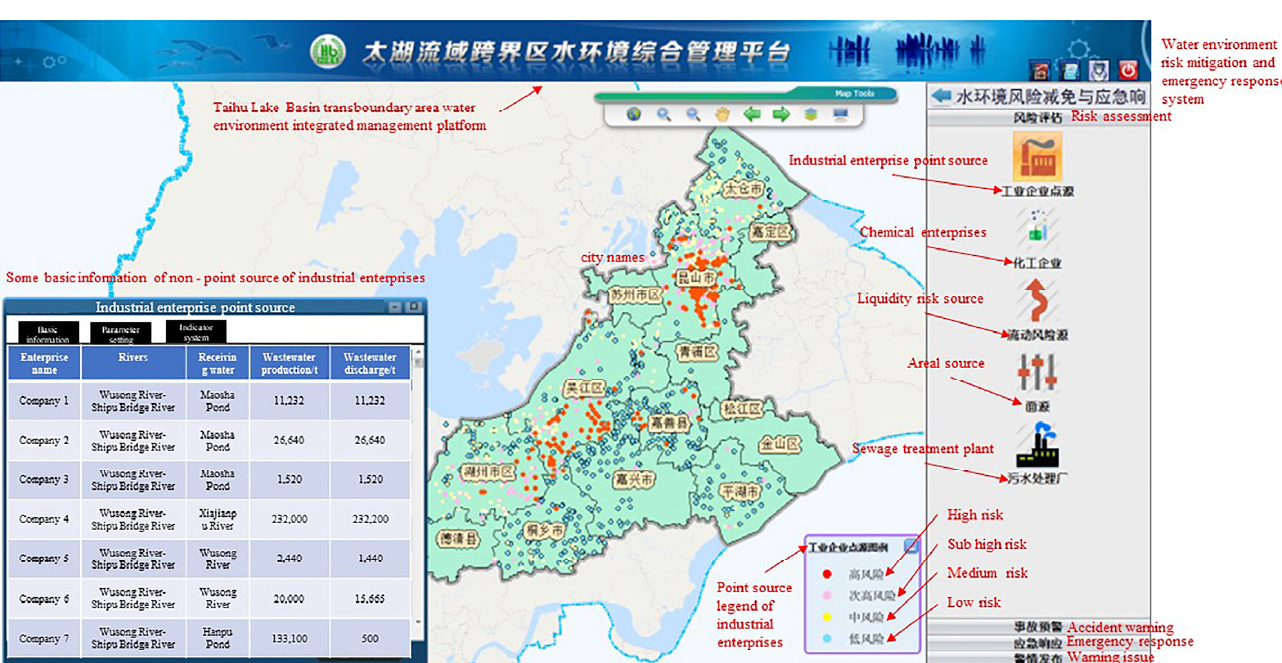
Figure 7. Point source risk assessment results for the industrial enterprises.